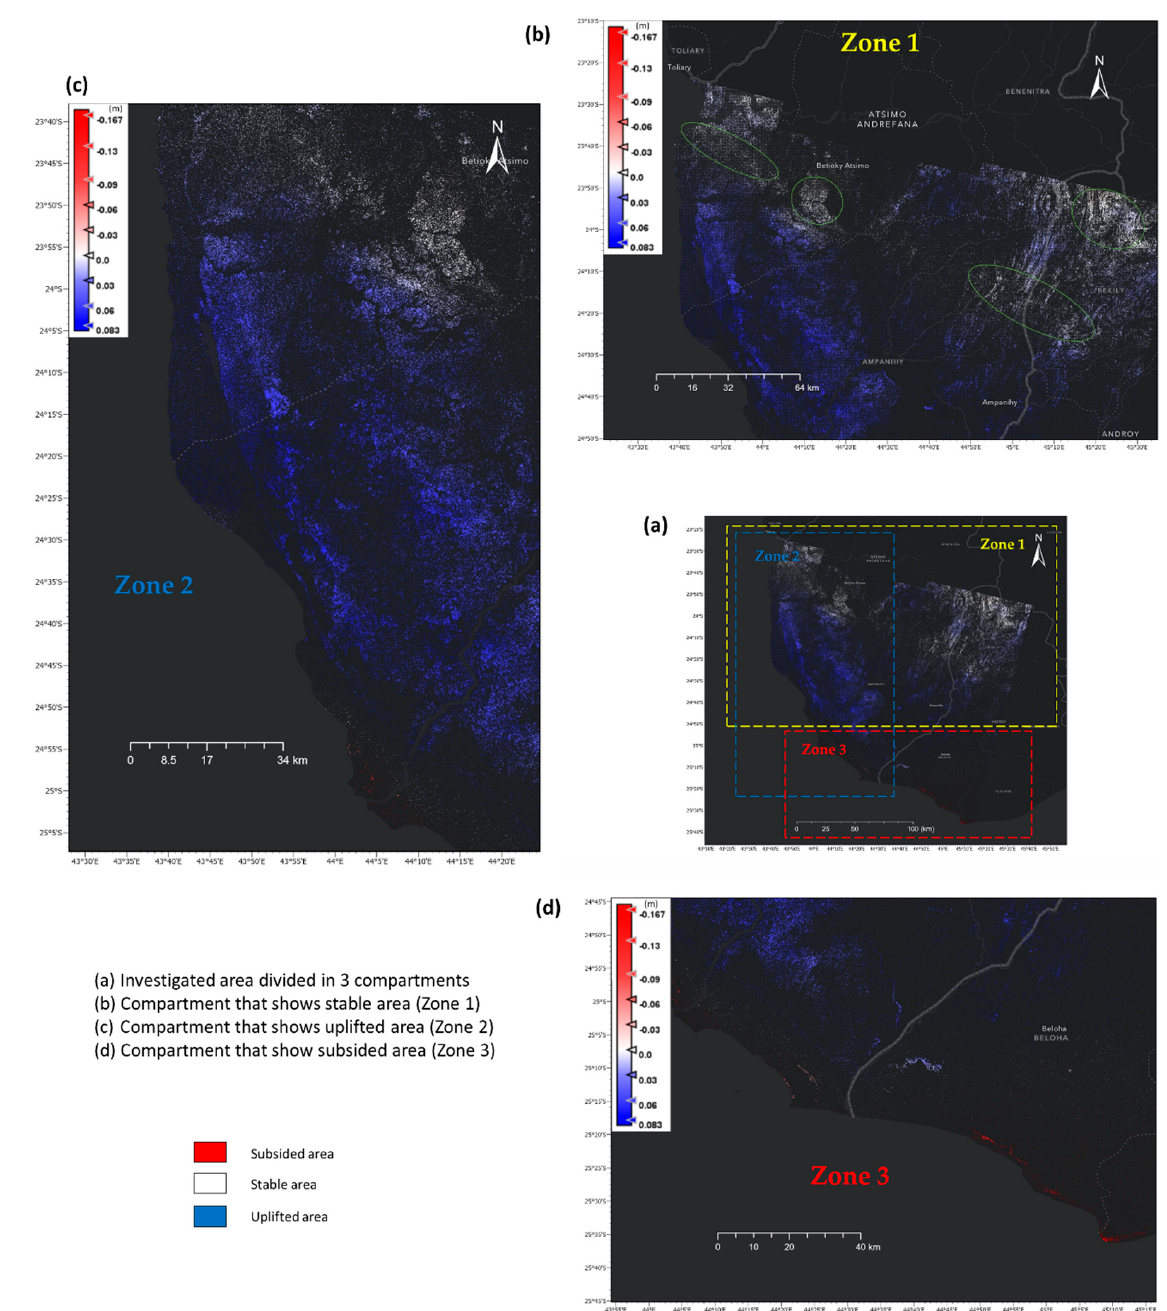
Figure 5. The 6-month land subsidence of the great south-western part of Madagascar from the Sentinel data, in which ( a ) represents the investigated area divided into three compartments; ( b ) shows the stable area, characterized by white color (in Zone 1); ( c ) shows the uplifted area, characterized by blue color (in Zone 2); and ( d ) shows where subsidence occurred, characterized by red color (in Zone 3).